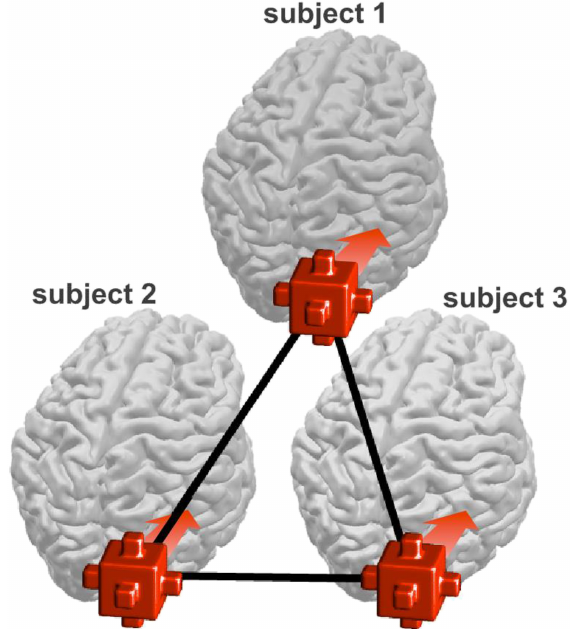
Figure 4 . Intersubject information mapping with searchlights in a common space. We can fi nd brain regions encoding common information in multiple subjects by moving spherical searchlights through their brains and analyzing for intersubject information in the local activity patterns at each location. In the simplest implementation, the searchlights are placed at corresponding locations in a common brain space such as Talairach space at each